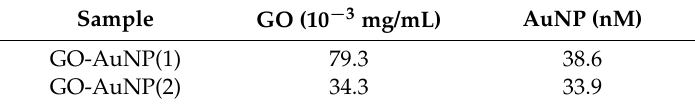
Table 2. Concentration of GO and AuNP in the hybrid GO-AuNP nanocomposites for pellet 1 and pellet 2